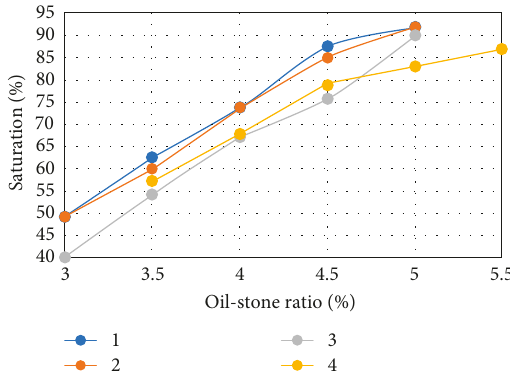
Figure 1: Relation between AC-16 relative bulk density and oil- stone ratio.